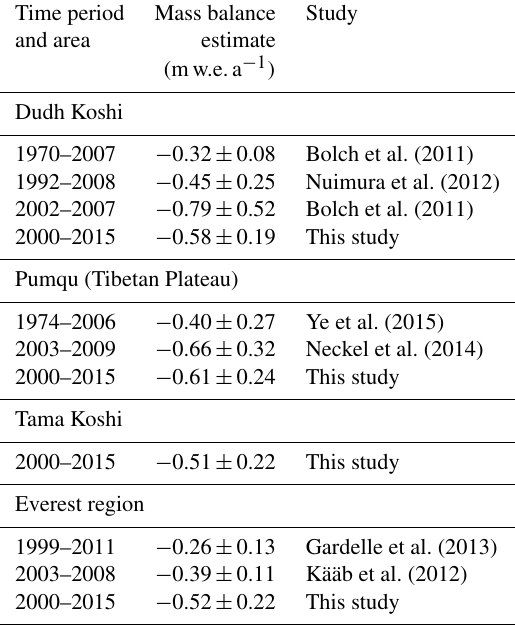
Table 3. Mass balance estimates (from geodetic and altimetric stud- ies) for the broader Everest region and comparable subregions/